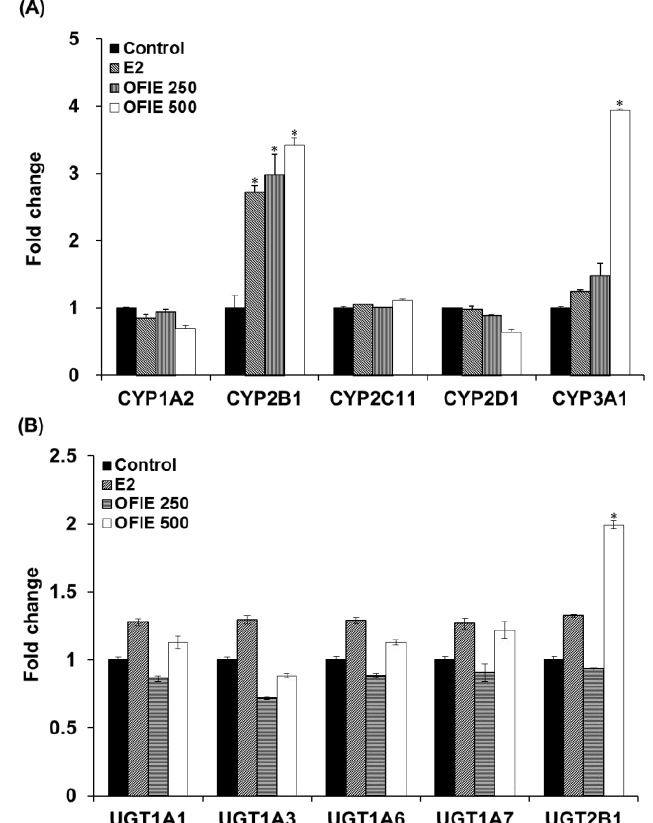
Figure 3. The relative amount of products formed in cytochrome P450 (CYP) ( A ) and Figure UDP-glucuronosyltransferase (UGT) isozyme-catalyzed reactions ( B ) by liver microsomal fraction